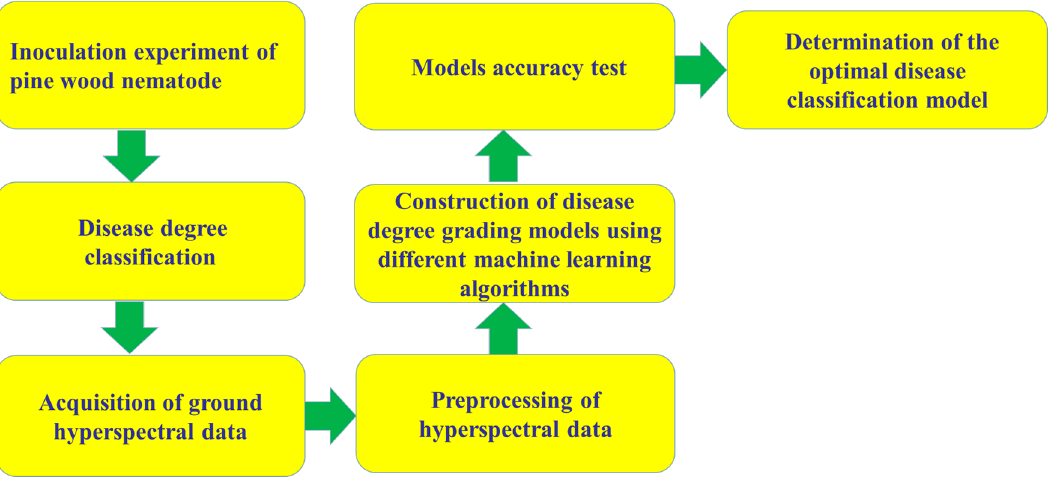
Figure 4. Construction of PWN grading models. PWNL: pine wood nematode, Bursaphelenchus xylophilus